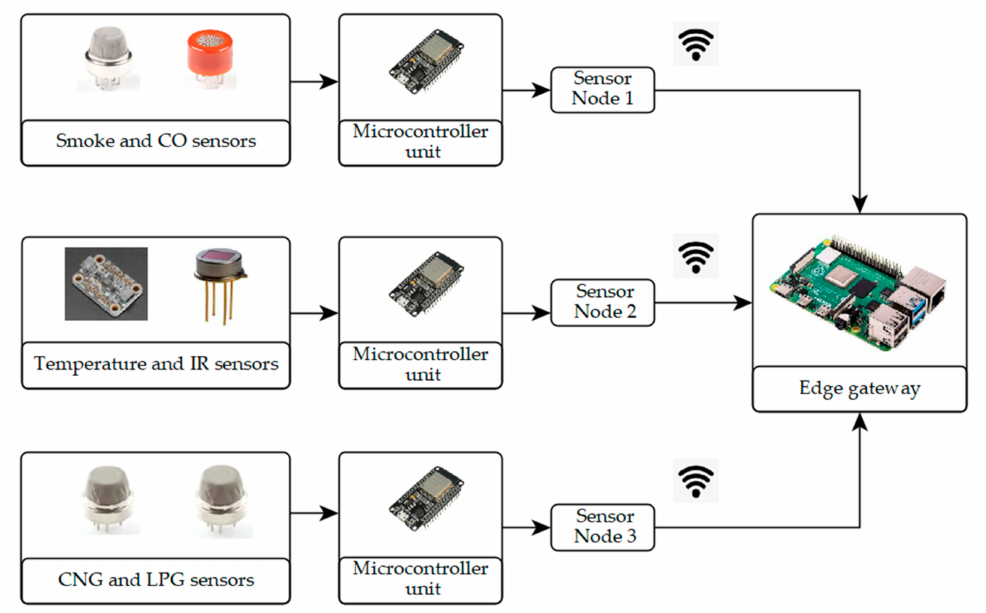
Figure 4. Connectivity diagram depicting the sensors, the microcontroller unit, and the edge